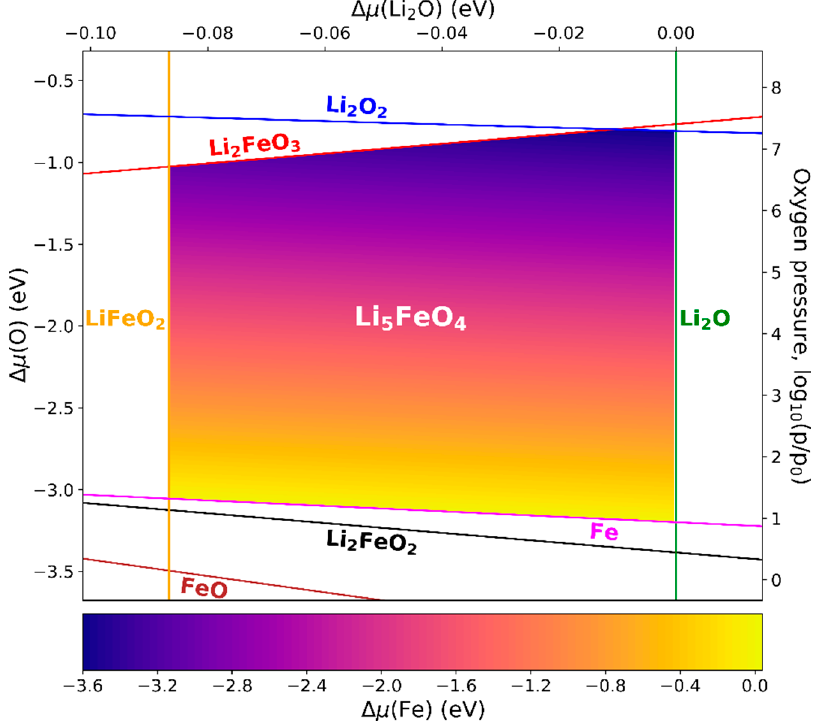
Figure 5. Phase diagram of Li 5 FeO 4 with respect to the chemical potentials of Li 2 O and oxygen. The vertical axis on the right is assigned to the corresponding oxygen gas pressure at a temperature of 1300 K ( p 0 = 1 atm). The chemical potential of Fe is visualized by color coding. The lines mark the transitions to the denoted competing phases.